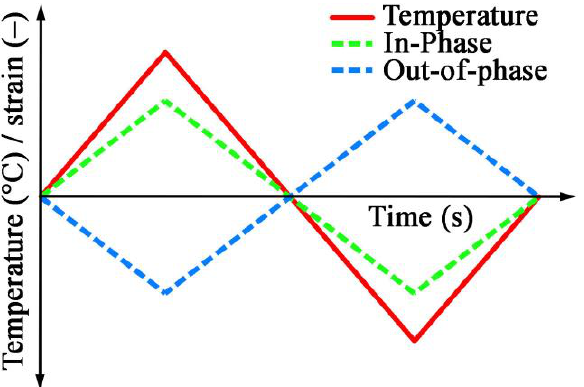
Figure 3. Time courses of temperature and mechanical strain for IP and OP loading.